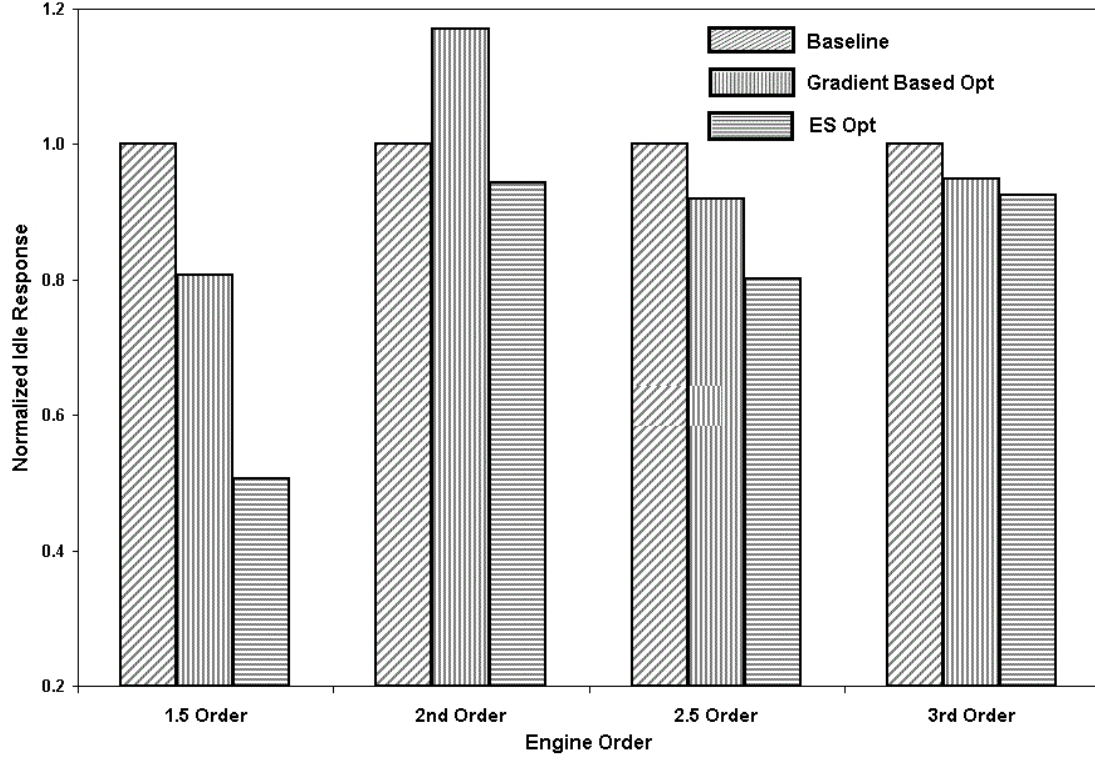
Fig. 12. Idle shake response at the driver’s seat bolt location in the full-vehicle system different engine orders. (cid:17) (cid:18) The magnitude of solution vectors, P =